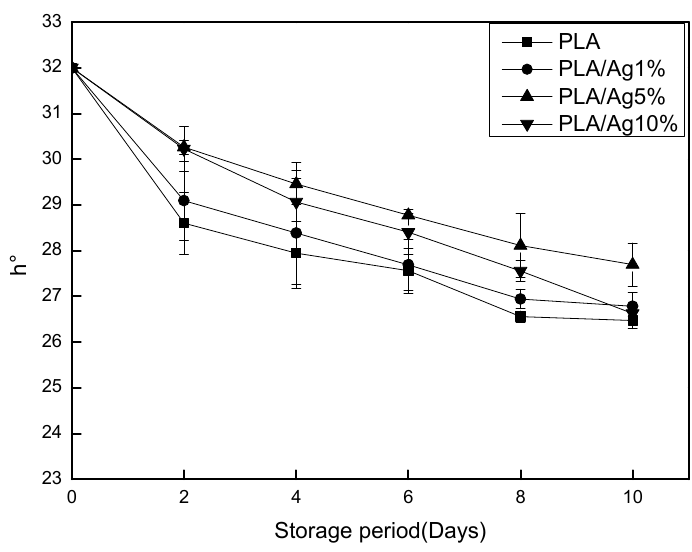
Figure 5. Effect of different concentration of nano-Ag active packages on the hue angle of strawberry stored at 4 ± 1 °C for 10 days. Data are presented as mean ± standard deviation.